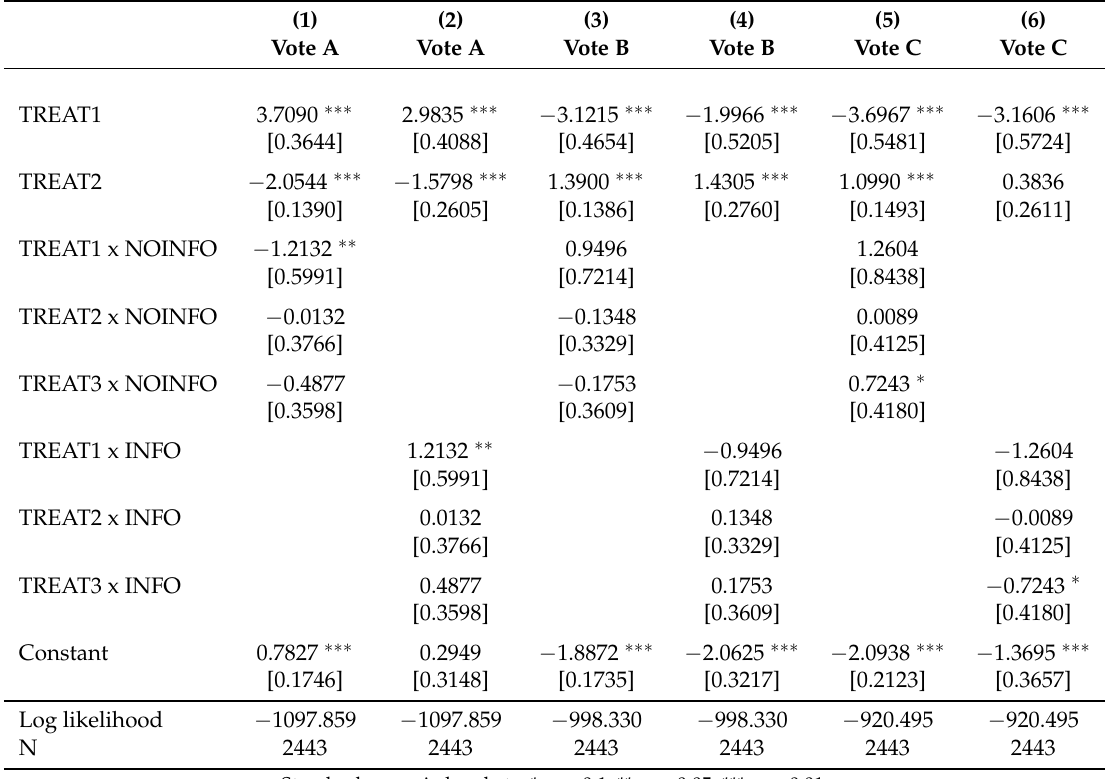
Table 9. Treatment and information (posting posteriors) effects on voting of type a .